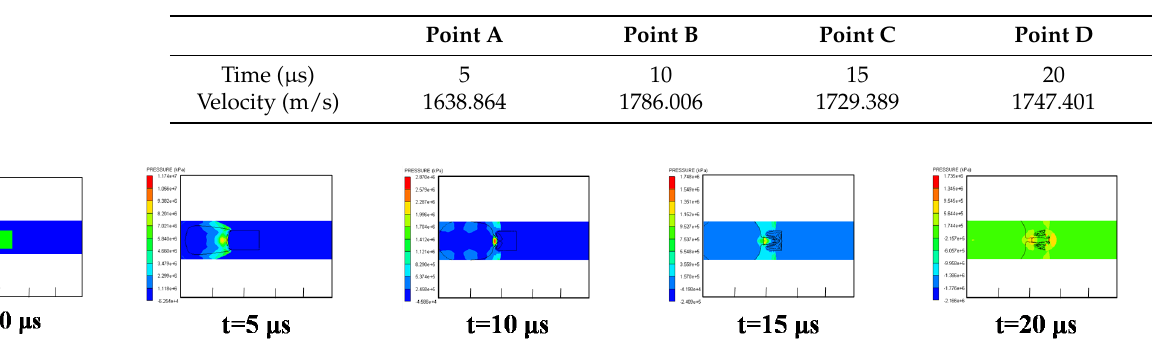
Table 10. Parameters of data points in the pit stage.